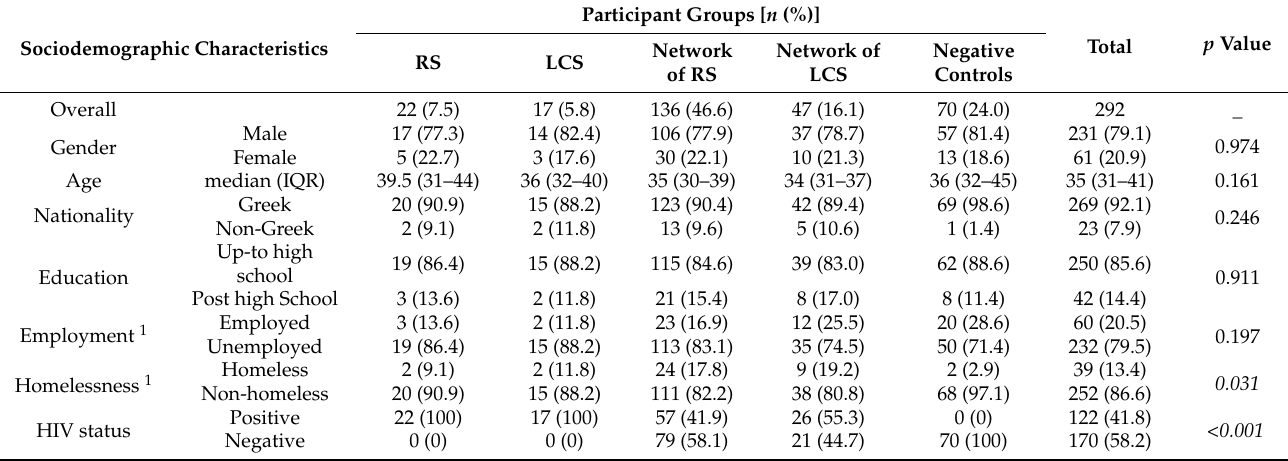
The Chi-squared test was used to test the difference in the frequencies and the Kruskal–Wallis equality-of-populations rank test was used to test a difference in the age distribution. p Values in italics stand for statistically significant differences between groups ( p <